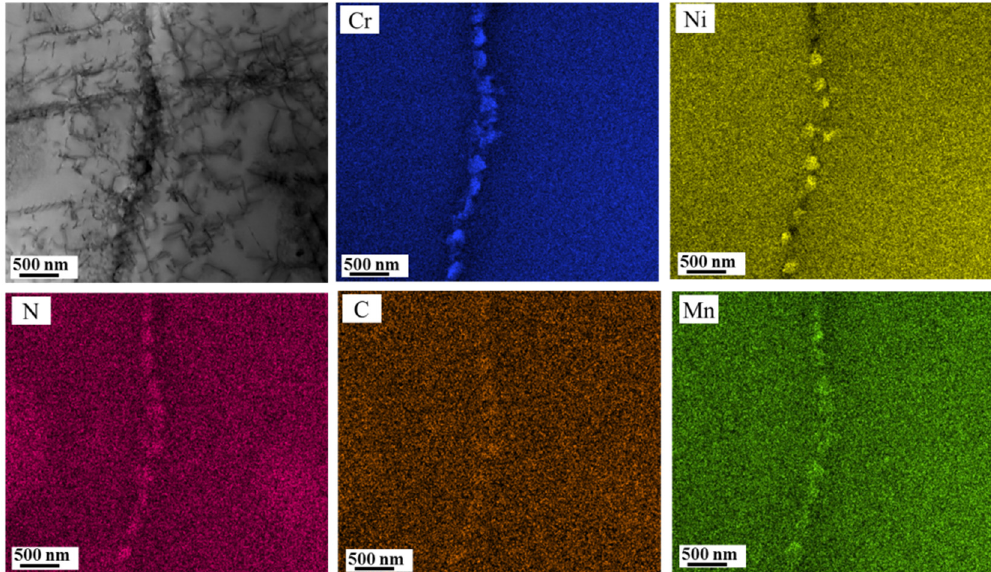
Figure 8. EDS maps from the weld metal and as-welded samples.